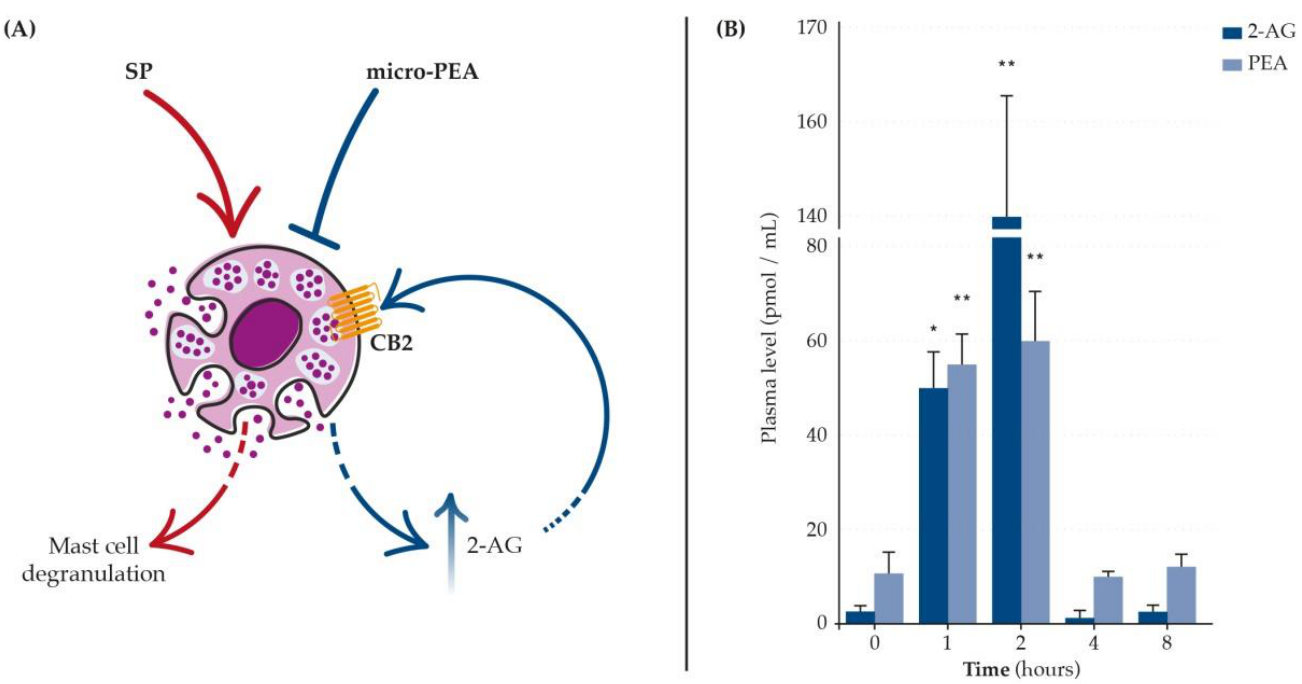
Figure 3. PEA may act on its molecular targets either directly or indirectly by increasing the agonism toward endocannabinoid receptors for which it has a low affinity. The latter mechanism is referred to as the “entourage effect”. The figure illustrates the in vitro ( A ) and in vivo ( B ) demonstrations of the entourage effect of bioavailable formulations of PEA (i.e., micro-PEA, please see next paragraph for further details) through increasing the levels of the endocannabinoid 2-AG. ( A ) Indirect agonism of micro-PEA on CB2 underlies the inhibitory effects on SP-induced mast cell degranulation, medi- ated by the stimulation of 2-AG biosynthesis [57]. ( B ) Following a single dietary supplementation with micro-PEA to hypersensitive Beagle dogs, not only plasma levels of PEA but also plasma levels of 2-AG significantly increase (* p < 0.05 and ** p < 0.001 versus the basal levels, time 0) [3]. ( B ) is slightly modified from [3]. 2-AG = 2-arachidonoylglycerol, CB2 = cannabinoid receptor type 2, mi- cro-PEA = micronized or ultramicronized palmitoylethanolamide, SP = substance P. To date, the molecular mechanisms of other ALIAmides are much less investigated than PEA’s. Besides increas ing PEA levels, as previously mentioned, these fatty acid am- ides are suggested to interact with different receptors. PGA, for example, is considered to exert its protective function through a toll-like receptor 4 antagonism [94], while the pre- cise molecular targets of Adelmidrol are still debated [55,95]. 4. Key Pharmacokinetic Issues A key aspect that has to be taken into account when dealing with the use of ALIAmides for health purposes is their respective physicochemical features. Some ALIAmides are more appropriate for oral use, while others are particularly suitable for topical applications thanks to their amphipathic nature (e.g., Adelmidrol) [95,96]. PEA and PGA are both highly lipophilic compounds (log p > 5) [97,98], with their oral use being limited by their intrinsic low dissolution rate, absorption, and bioavailability [98,99]. Particle size reduction is one of the most compelling and practical strategies for improving pharmacokinetics and boosting functional properties following oral admin- istration [100,101]. Provided the route of administration is oral, most of the studies pre- sented below investigated “ micro-PEA ” and “ micro-PGA ” accordingly. Micro- ALIAmides result from micro-grinding a particular ALIAmide — either alone or together with adjuvants (typically antioxidants) — in order to downsize the particles to diameters in the range of 0.6 – 10 μm . Indeed, after the administration of micro-PEA, the plasma